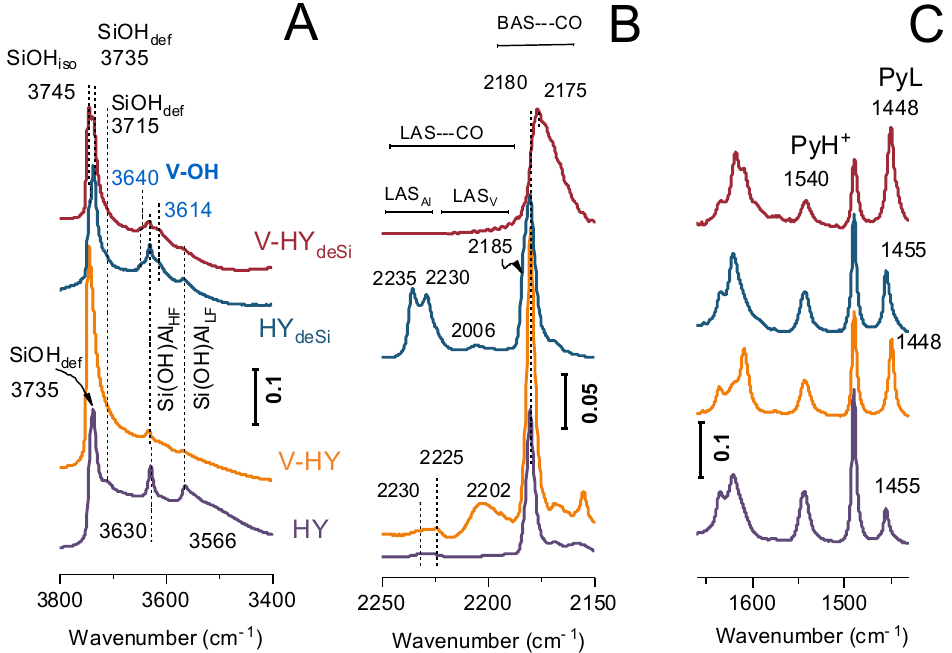
Figure 2. The FT-IR spectra of the V zeolites and their H counterparts: in the region of O-H stretching Figure 2. The FT ‐ IR spectra of the V zeolites and their H counterparts: in the region of O ‐ H stretching vibrations ( A ), upon the sorption of carbon monoxide ( B ) and pyridine ( C vibrations ( A ), upon the sorption of carbon monoxide ( B ) and pyridine ( C ).